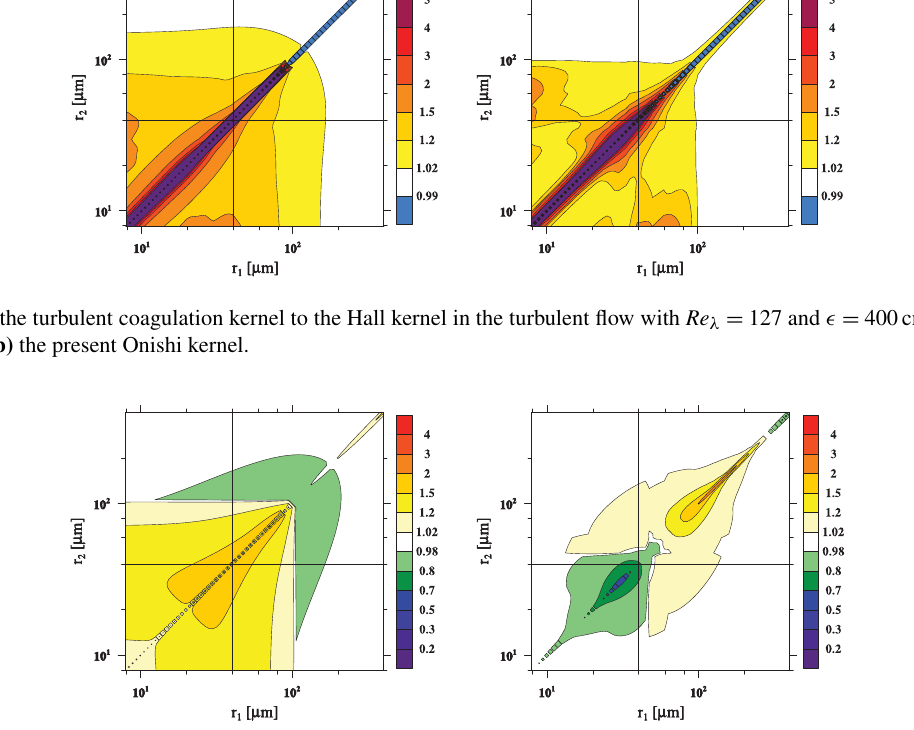
Figure 6. Ratio of the coagulation kernel for Re λ = 10 4 to that for Re λ = 10 3 . (a) Ayala–Wang kernel and (b) the present Onishi